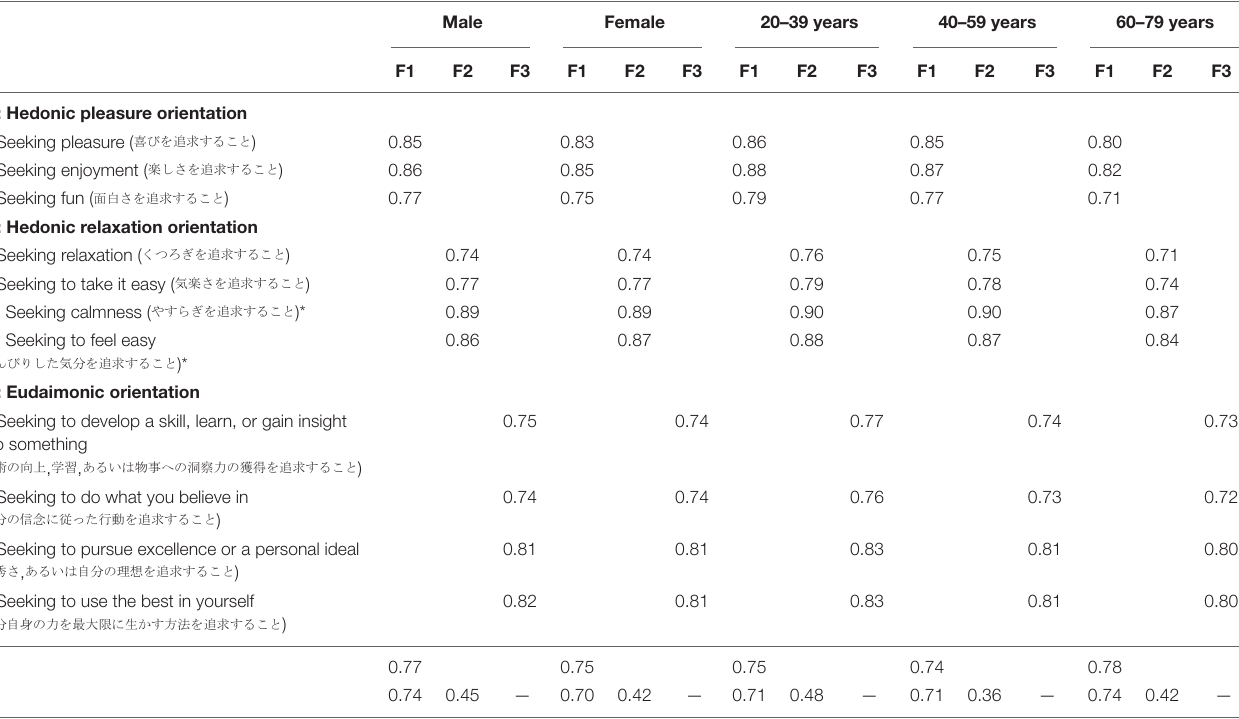
TABLE 2 | Strict invariant standardized factor loadings and factor correlations for the Japanese HEMA scale (11